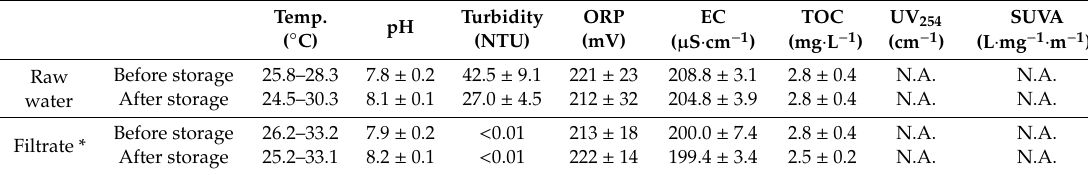
Table 2. Raw water and filtrate * quality (March 2015).